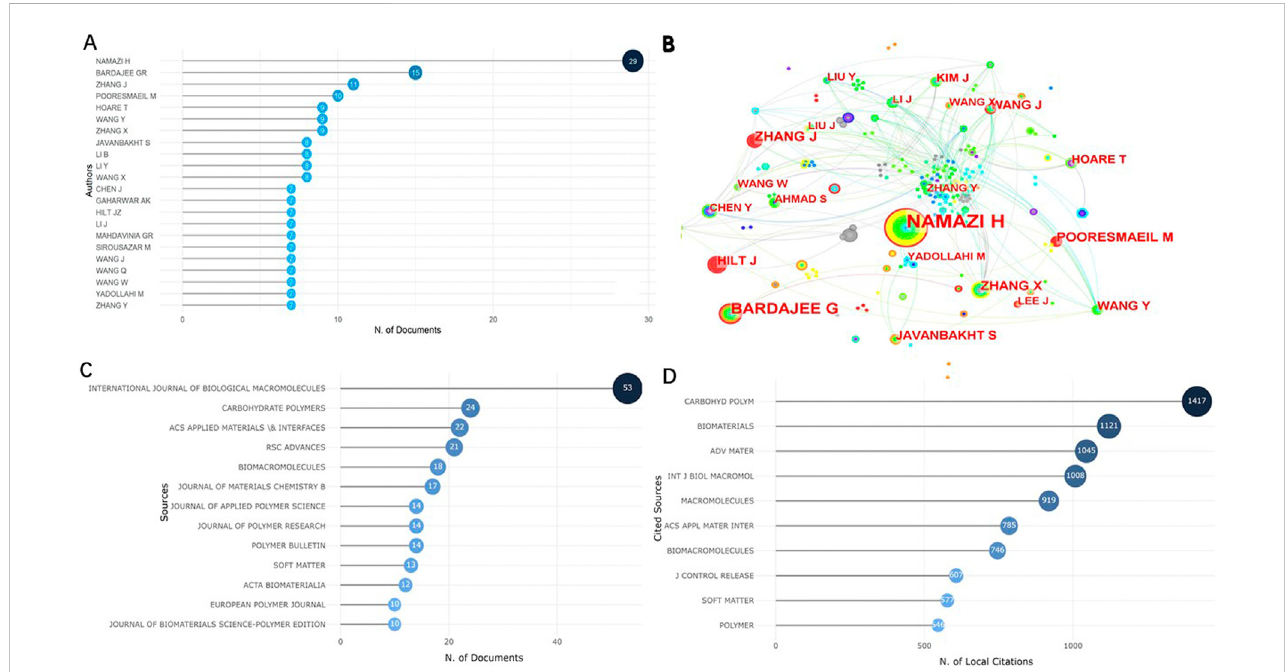
FIGURE 5 Visualized analysis of authors and journals concerning the publications of NHs applications for drug delivery. (A) The top 10 authors with the most published papers; (B) The network map of cooperative relations between authors. (C) The top 10 most productive journals; (D) The top 10 journals with the most local cited publications.